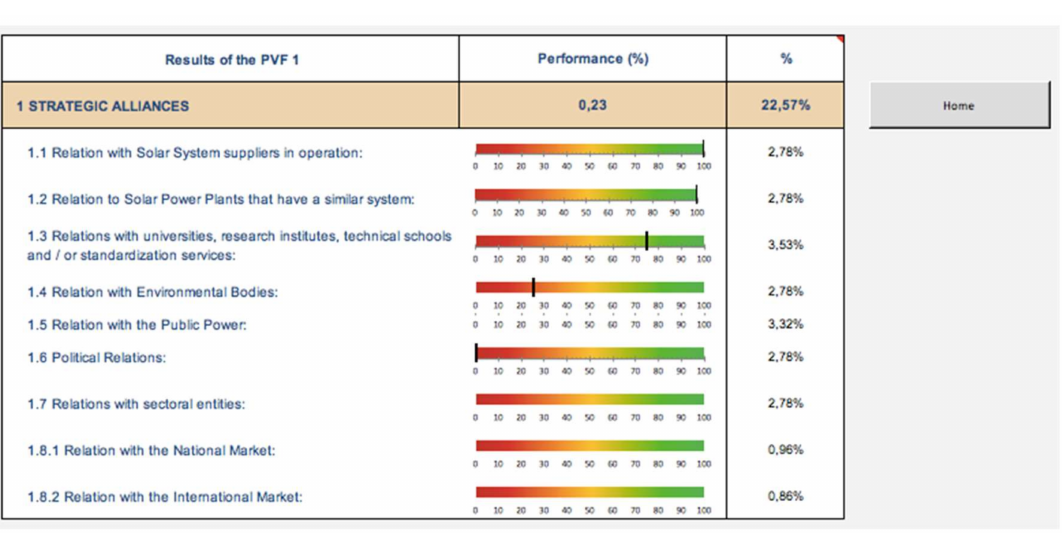
Figure 6. Example of the report screen generated through the example of the indicators related to FV 1—Strategic